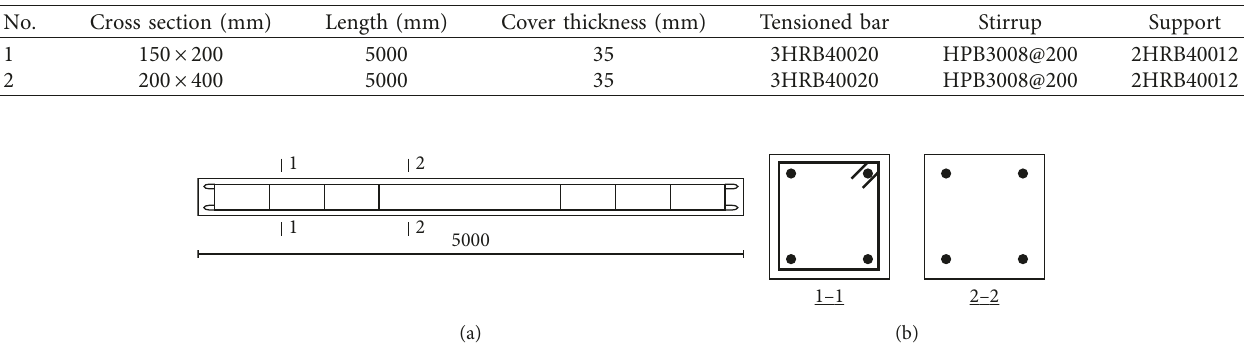
Figure 3: Comparison of results from finite element and experiments. (a) Measuring point 1. (b) Measuring point 2. (c) Measuring point 3. (d) Measuring point 4. (e) Measuring point 5. (f) Measuring point 6. (g) Measuring point Table 4: Basic parameters of coal gangue geopolymer concrete beams.